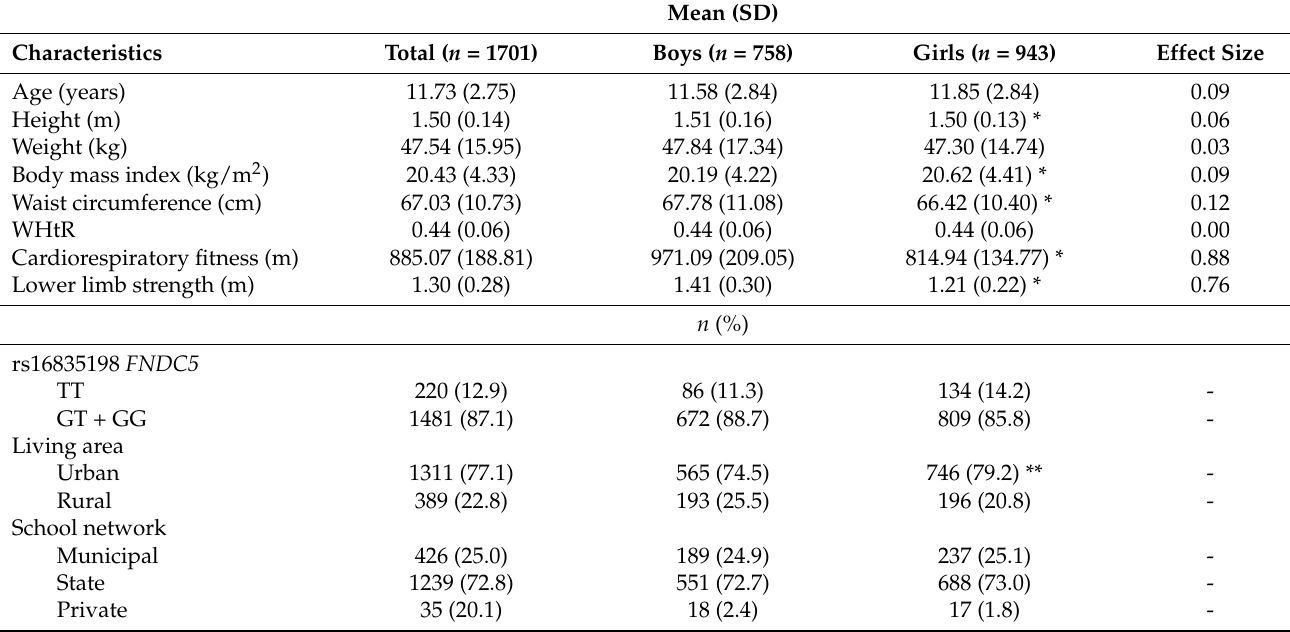
Table 1. Baseline sample characteristics by sex.